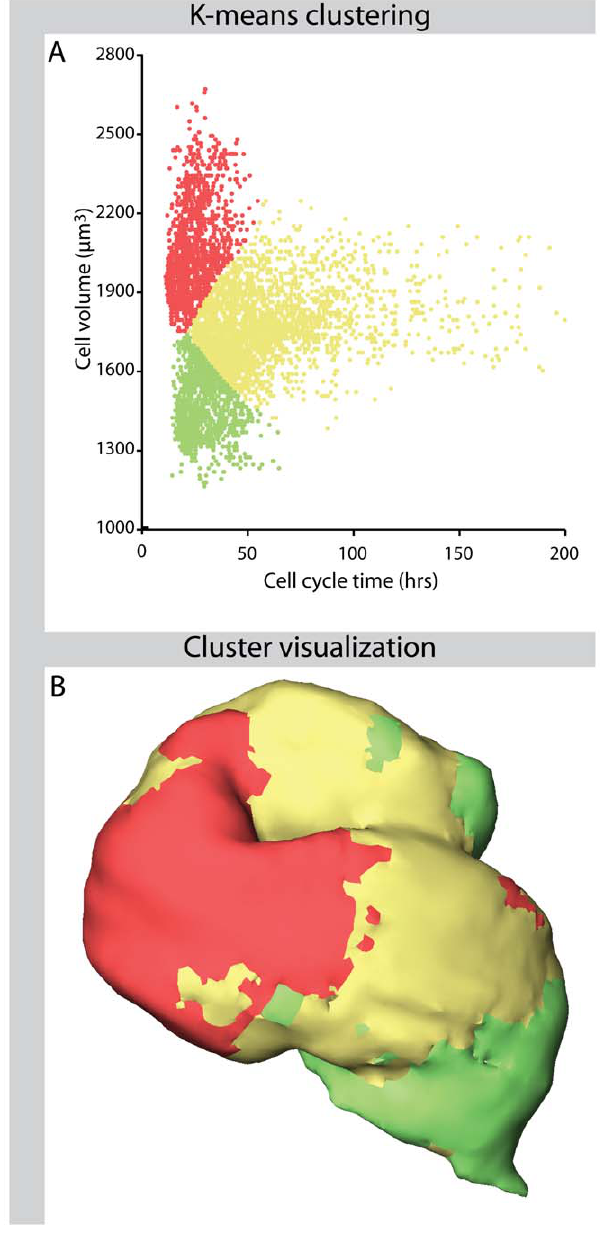
Figure 5. Cell size - cell cycle length clustering and visualisa- tion. Panel A shows a k-means cluster analysis of boxels based on their cell volume and their cell cycle length. Panel B shows the result of plotting cluster membership of each boxel into the HH12 myocardium reconstruction. Although spatial information was not used in the cluster procedure, the resulting clusters show clear spatial